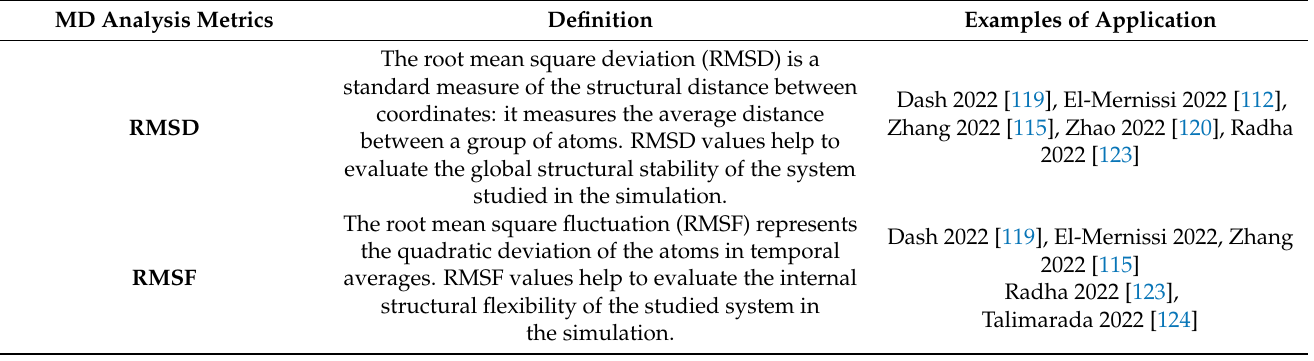
Table 3. A glossary of key parameters and procedures used to analyze observed conformational changes during MD